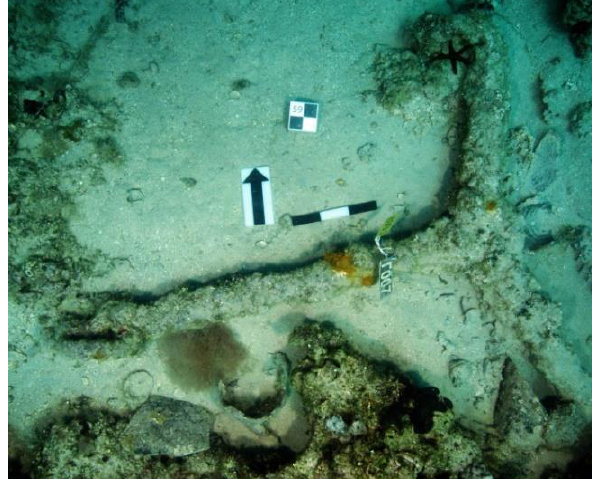
Figure 5: Byzantine anchor Y type (©V. Mentogiannis, H.I.M.A. 2015)